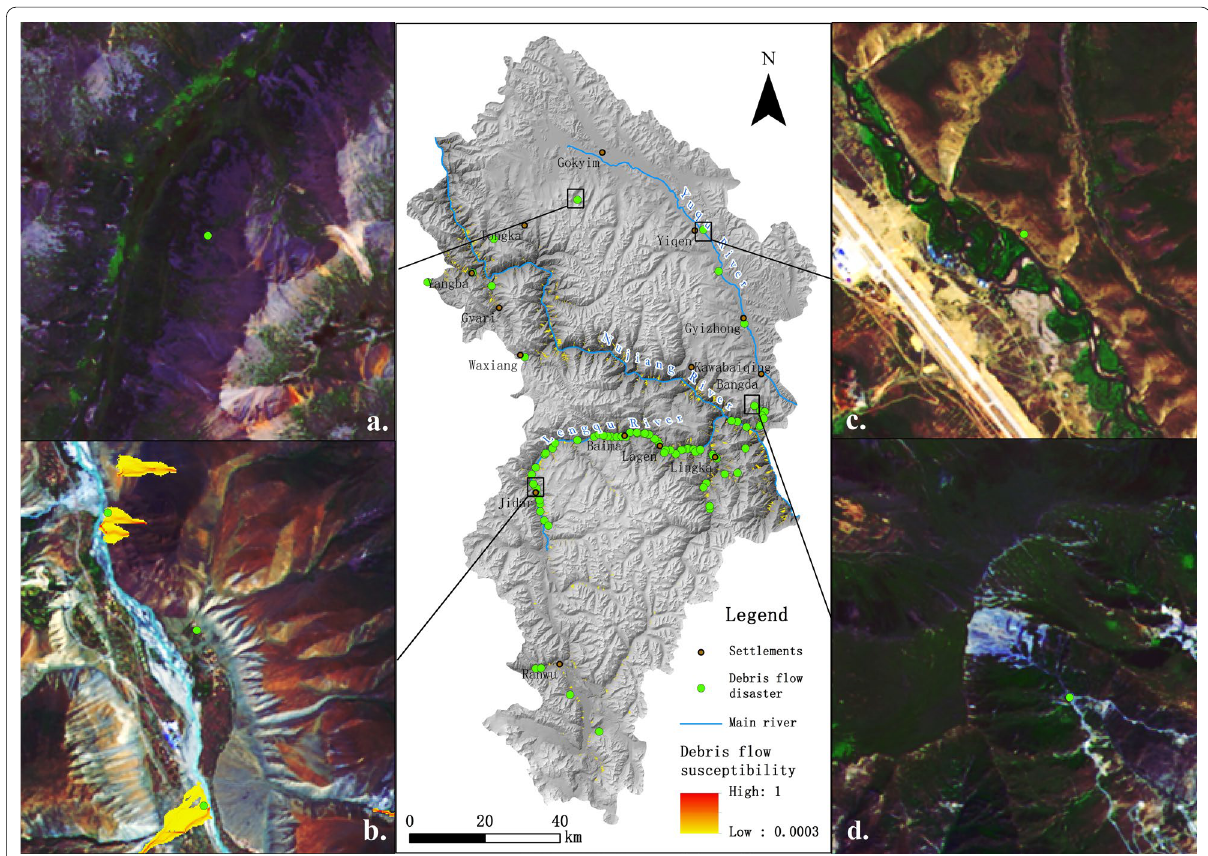
Fig. 7 Disaster occurrence points that fall outside the predicted area